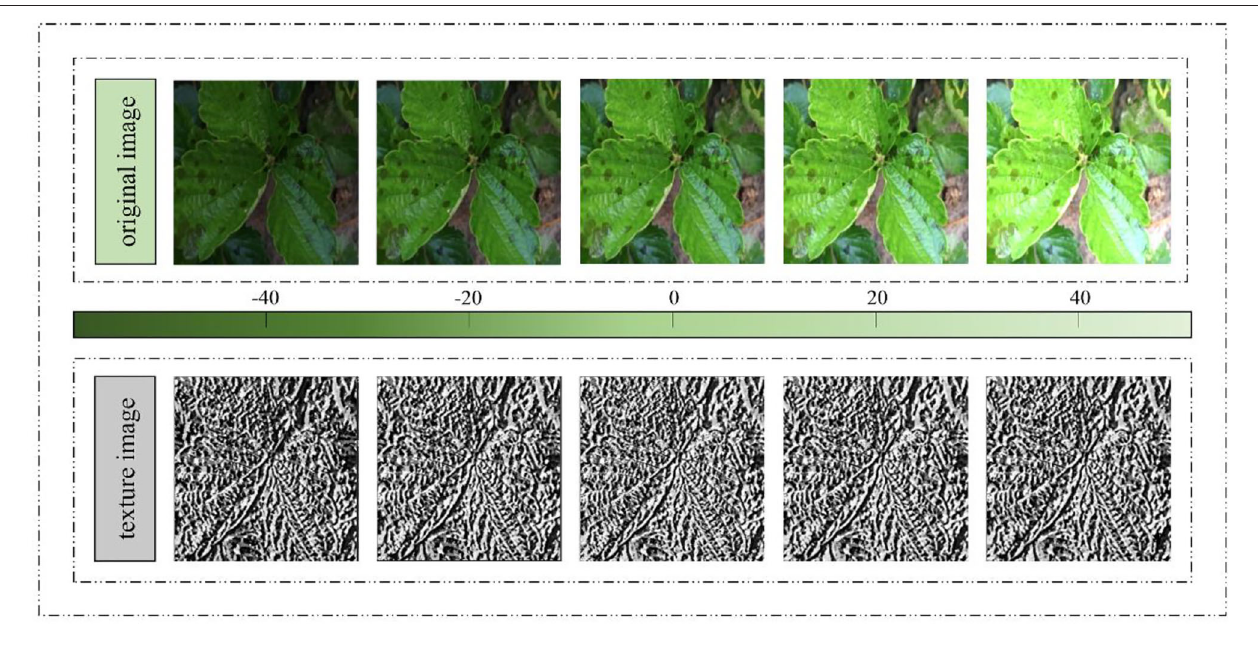
FIGURE 7 | Texture feature map of the same image extracted under different brightness.